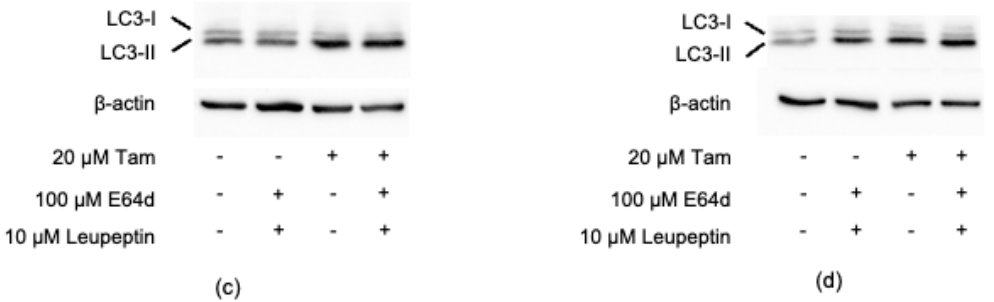
Figure 8. Overexpression of iron-binding proteins and activation of autophagy are both necessary to prevent Tam-induced lysosomal damage in breast cancer cells. ( a , b ) Susceptibility of MDA-MB-415 ( a ) and ZR-75-1 ( b ) cells overexpressing GFP, MT2A, FtH, or Hsp70 to LMP induced by treatment with 20 µ M Tam for 2 h. ( c , d ) Effect of treatment with 20 µ M Tam for 2 h on activation of autophagy in MDA-MB-415 ( c ) and ZR-75-1 ( d ) cells transfected as in ( a , b ); refer to Figure S8 for the original blots. For panels ( a , b ), data and statistical analysis are as in Figure 1. Panels ( c , d ) are representative of three independent